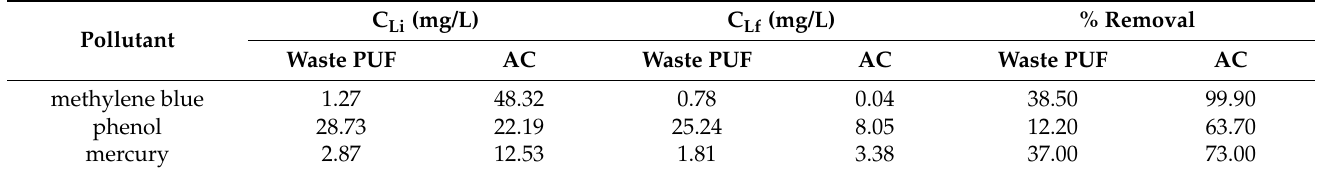
Table 5. Maximum removal efficiencies achieved in batch adsorption tests performed with waste PUF and AC (C Li : initial concentration in the liquid phase; C Lf : final concentration in the liquid